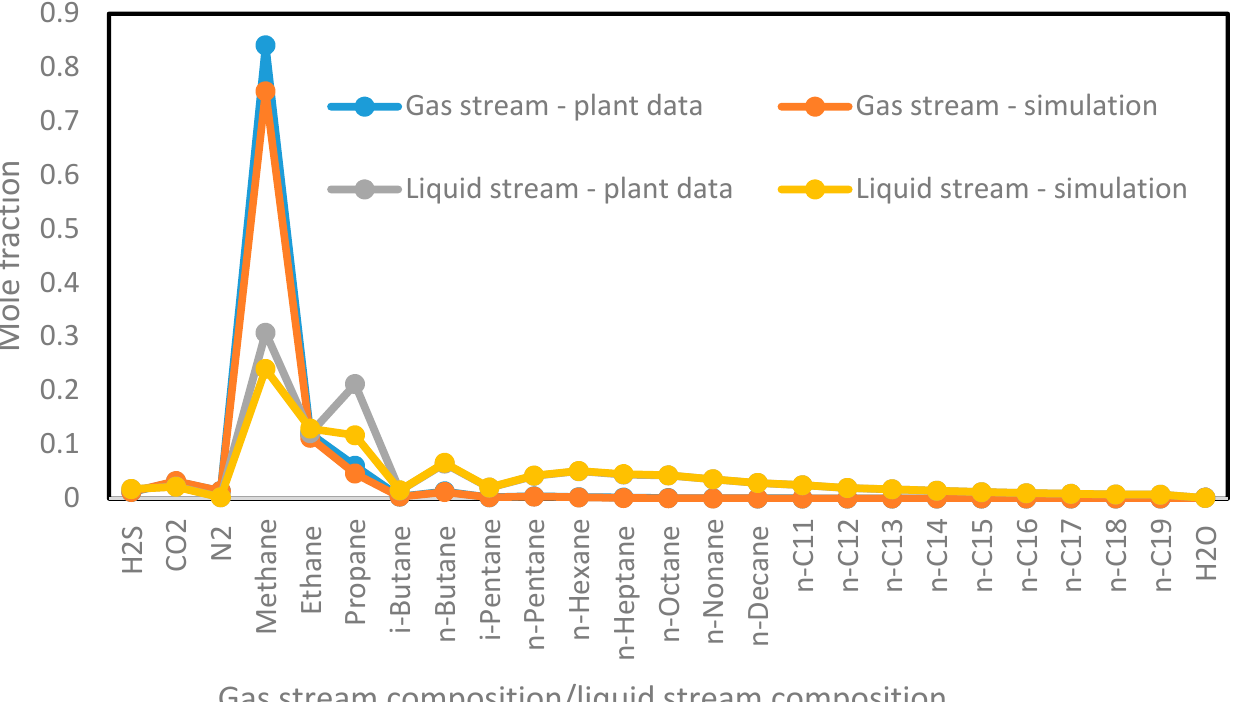
Figure 8. The composition of outlet gas and liquid streams for simulations and plant data.